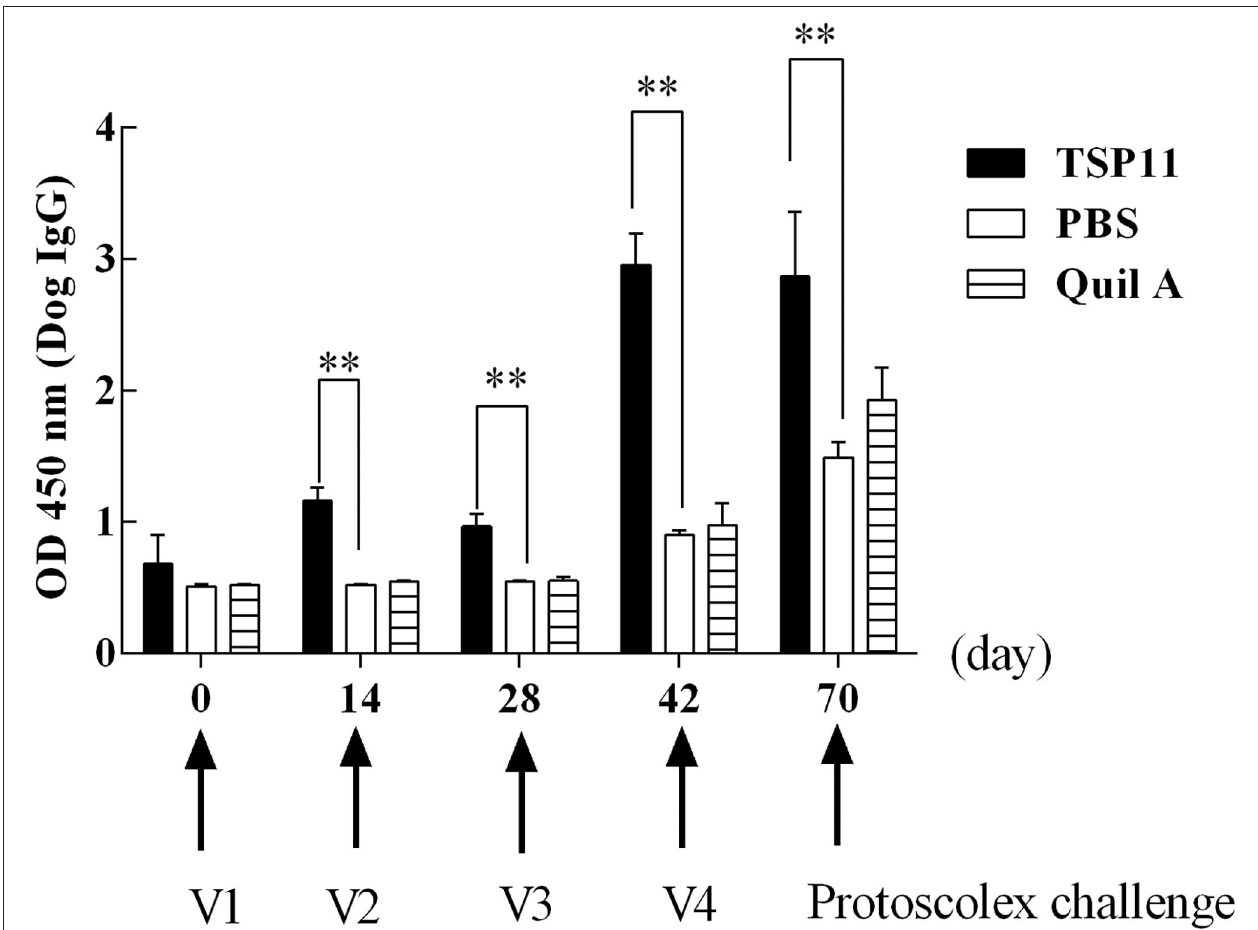
FIGURE 8 | Changes in antibody IgG levels in dogs vaccinated with rTSP11 + Quil A, Quil A alone, or PBS. * P < 0.05; ** P < 0.01.